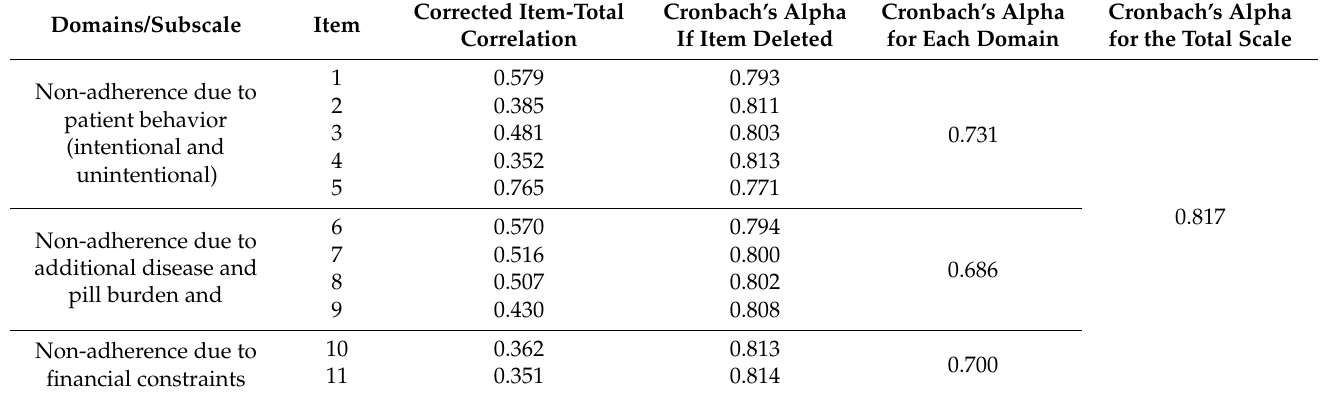
Table 2. Internal